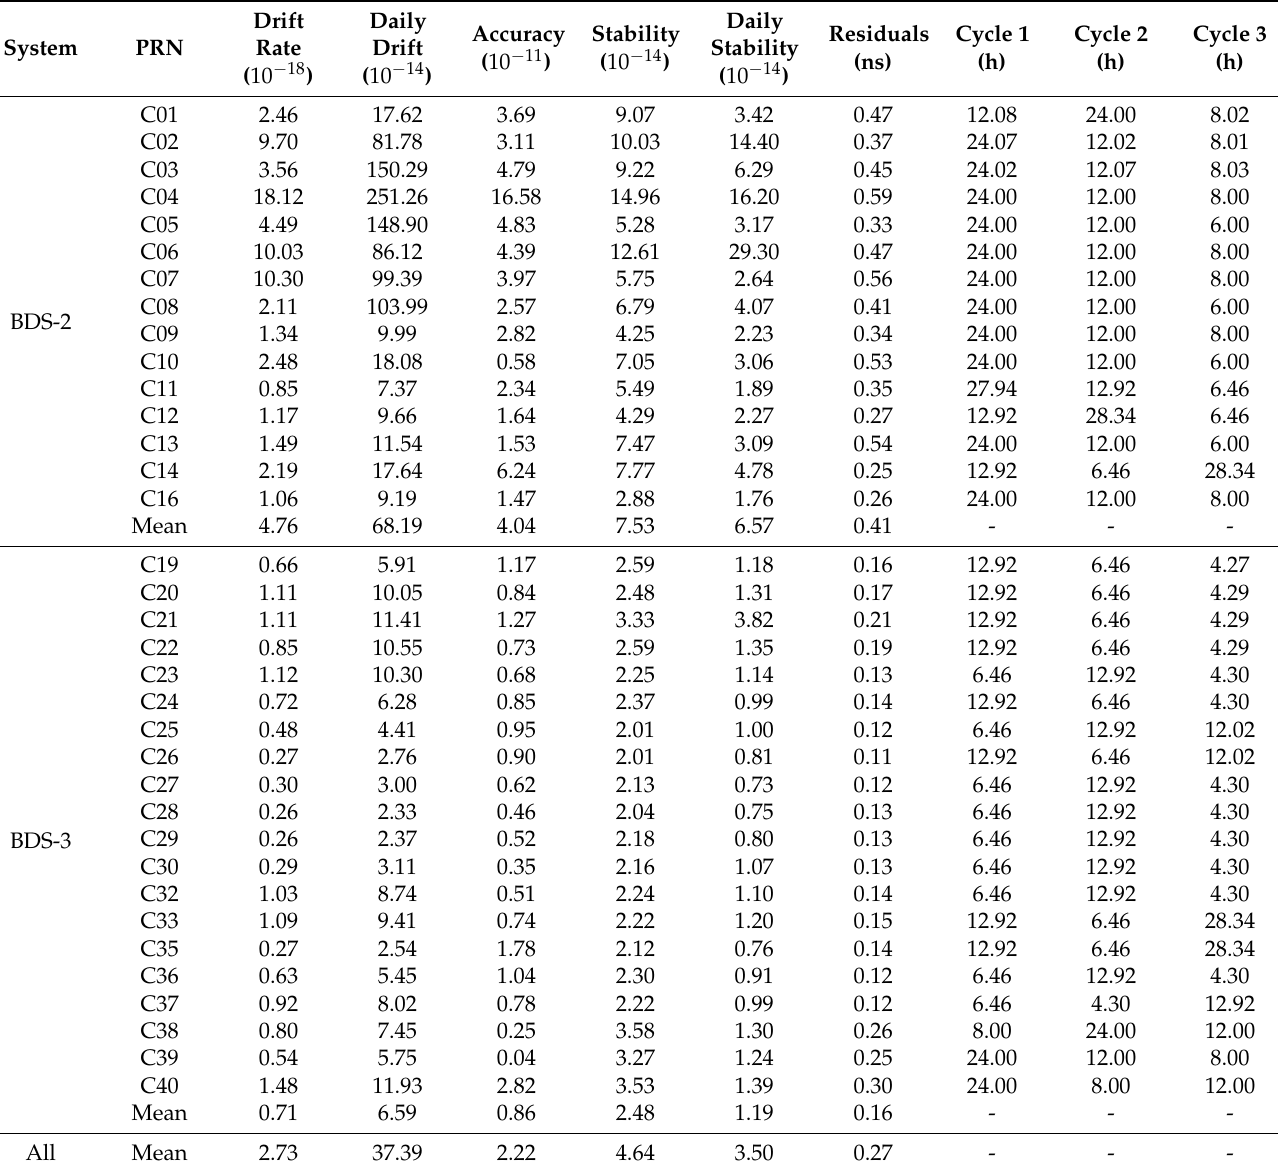
Table 2. Summary of performance indexes of BDS satellite atomic